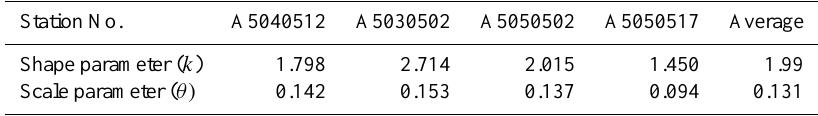
Table 5. Estimated gamma distribution parameters.